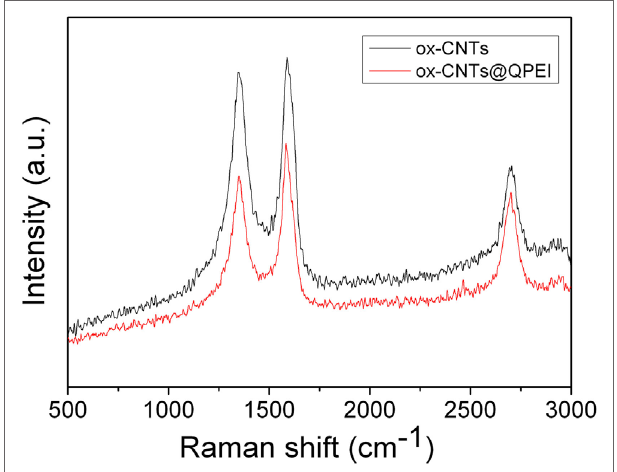
FigUre 1 | Raman spectra of ox­carbon nanotubes (ox­CNTs) (black) and ox­CNTs@QPEI